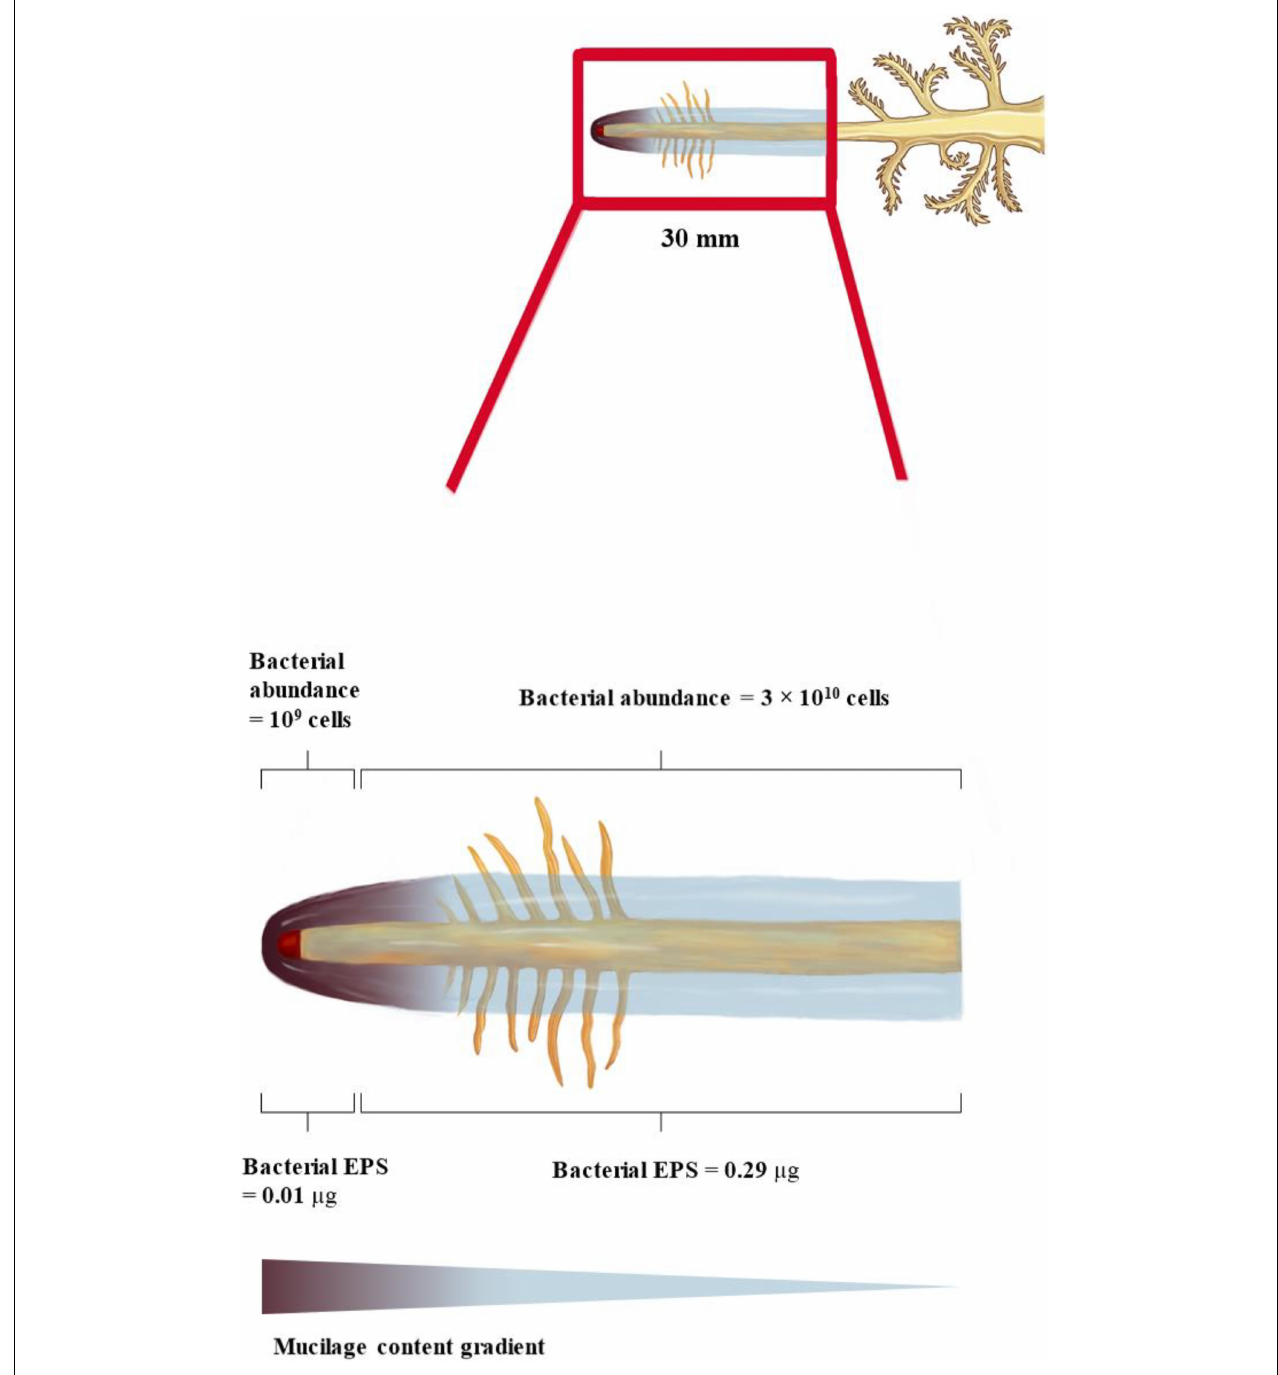
FIGURE 5 | Spatial and temporal model of mucilage biofilm and its bacterial abundance and EPS production along a maize root segment grown within 1 day (= 30 mm). Mucilage content decreases away from the root tip due to bacterial decomposition. Mucilage extent increases away from the root tip due to